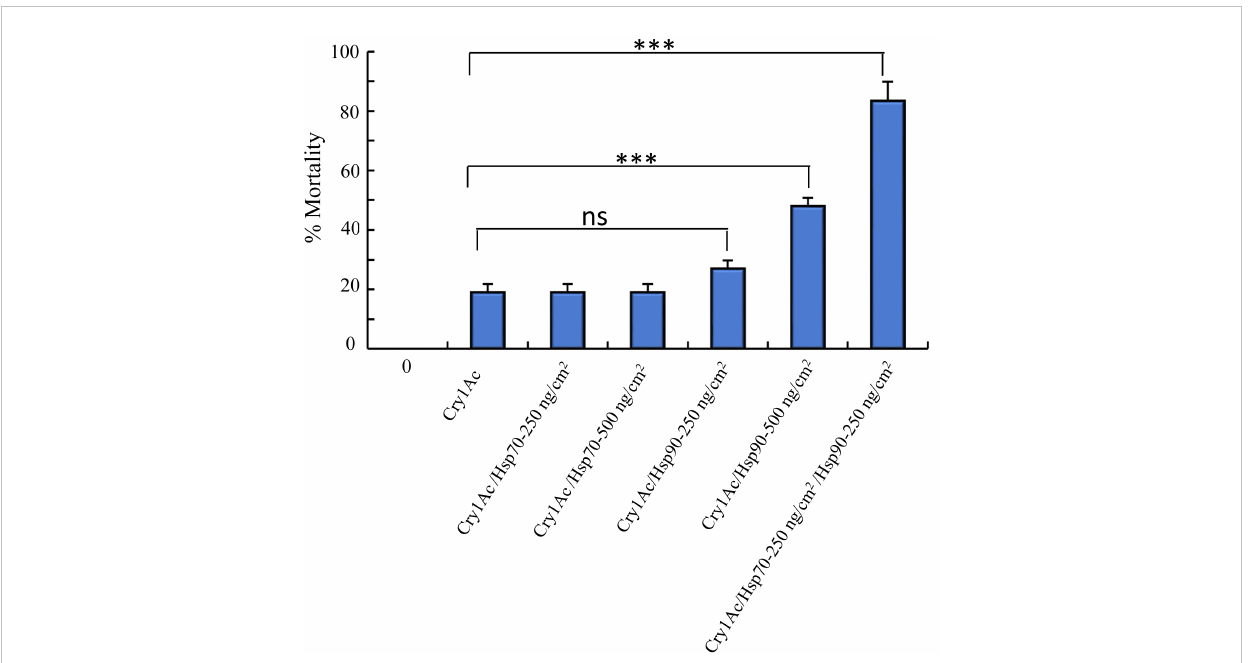
FIGURE 4 PxHsp70 and PxHsp90 recovers Cry1Ac toxicity against Plutella xylostella NO-QAGE Cry1Ac resistant strain. Percentage of mortality of Cry1Ac protoxin (25 ng/cm 2 ) against P. xylostella NO-QAGE strain in the presence of different concentrations of PxHsp70 (250 or 500 ng/cm 2 ), PxHsp90 (250 or 500 ng/cm 2 ) or Pxhsp70+PxHsp90 (250 + 250 ng/cm 2 ). Data with standard deviations represent means of three treatments using 24 larvae per treatment in each repetition. P values indicated statistically signi fi cant differences: *** p > 0.0001; ns, not signi fi cant difference.